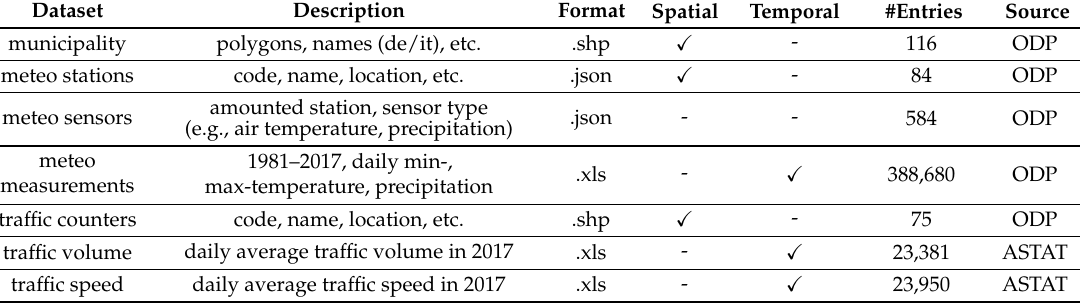
Table 1. Datasets used in this